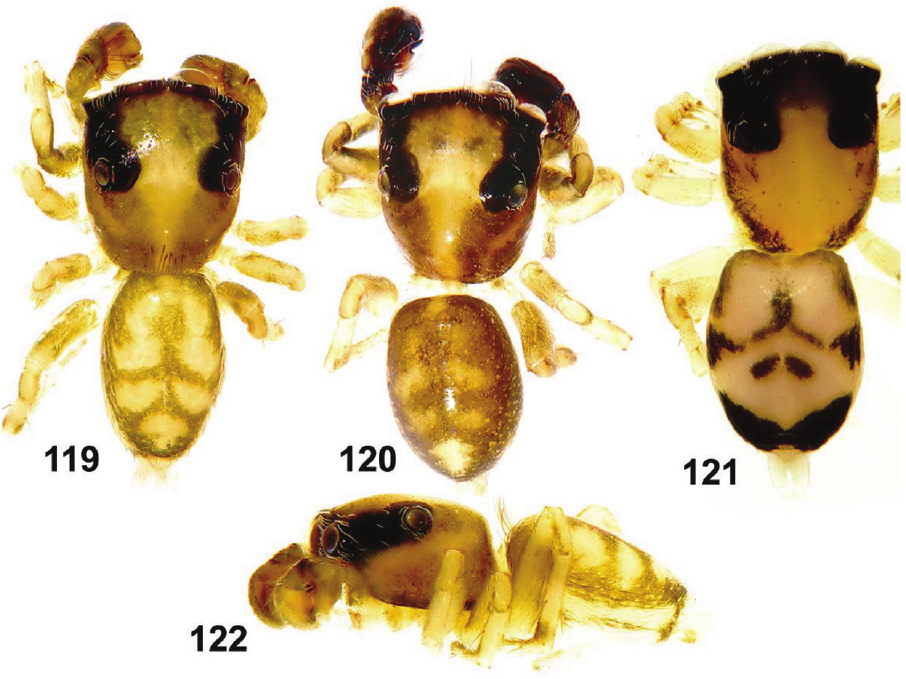
Figures 119–122. General appearance of Eupoa yunnanensis from Laos. 119, 120 male body, dorsal view 121 female body, dorsal view 122 male body, lateral view.